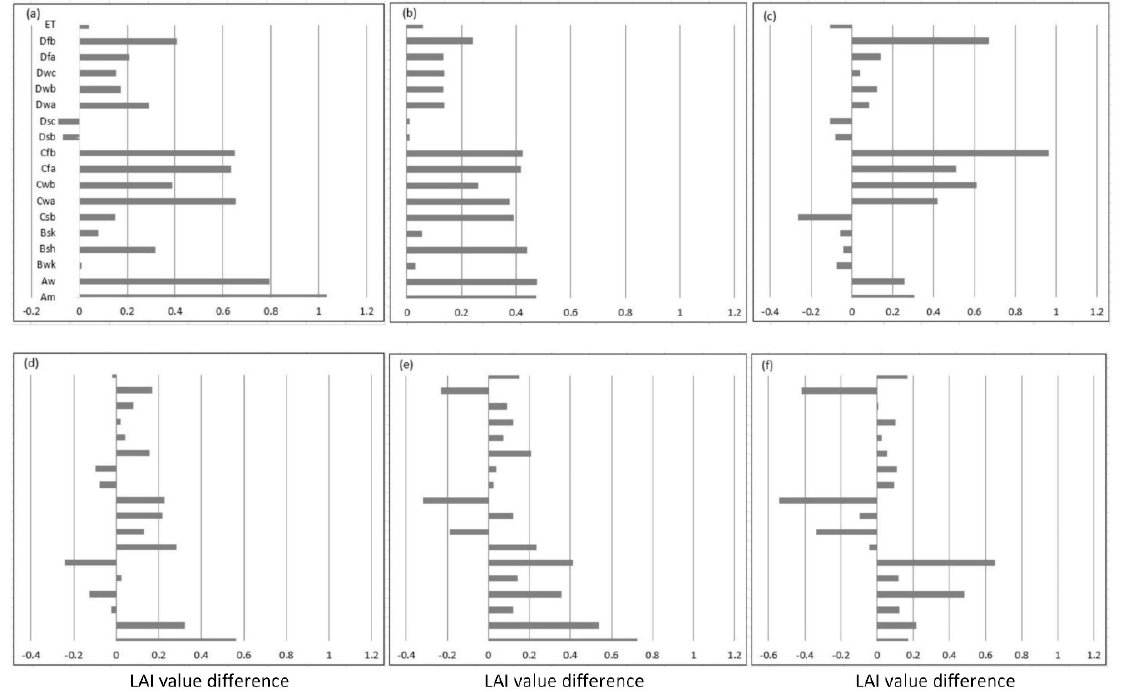
Figure 13. LAI value comparison for each climate type: ( a ) GLASS-MODIS; ( b ) GLOBALBNU-MODIS; ( c ) GLOBMAP-MODIS; ( d ) GLASS-GLOBALBNU; ( e ) GLASS-GLOBMAP; ( f ) GLOBALBNU-GLOBMAP.